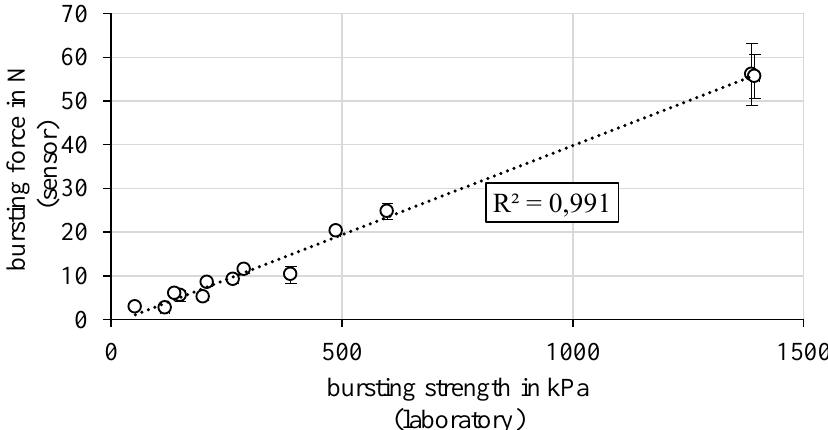
Figure 6. Correlation between the burst strength measured in the laboratory and the burst force measured by the sensor.